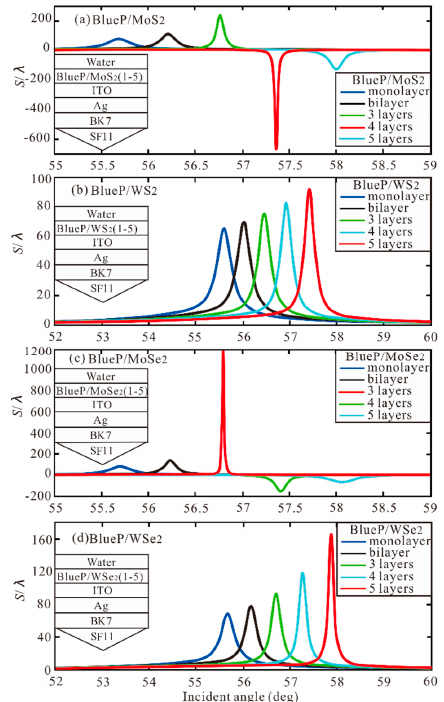
Figure 4. The GH shift with incident angle for different number of BlueP/TMDCs ( a ) BlueP/MoS 2 layers, ( b ) BlueP/WS 2 layers, ( c ) BlueP/MoSe 2 layers, ( d ) BlueP/WSe 2 layers.